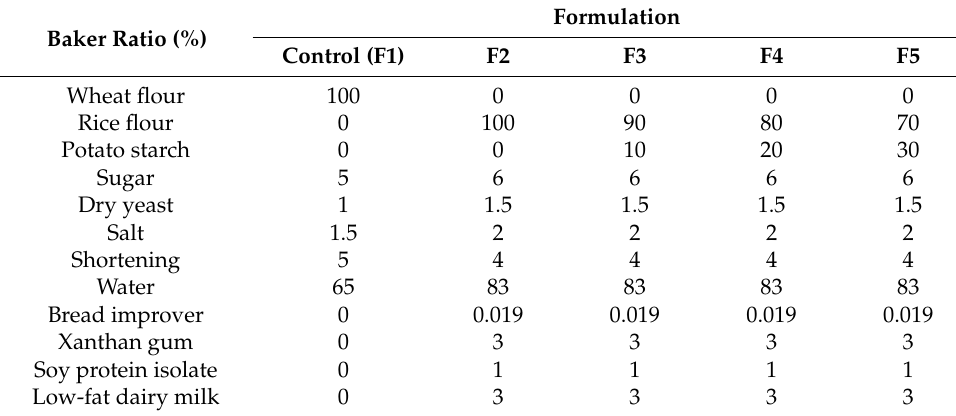
Table 1. The formulation utilised in the preparation of bread. Baker Ratio